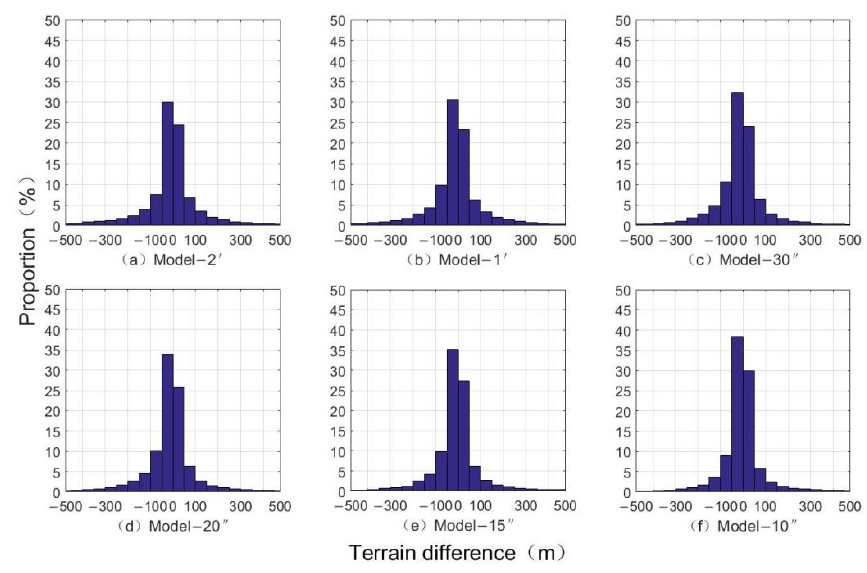
Figure 8. The proportion distribution of topographic differences of the Emperor Seamount Chain. Table 5. Difference data statistics at check points of various topographic models of the Emperor Seamount Chain (m).